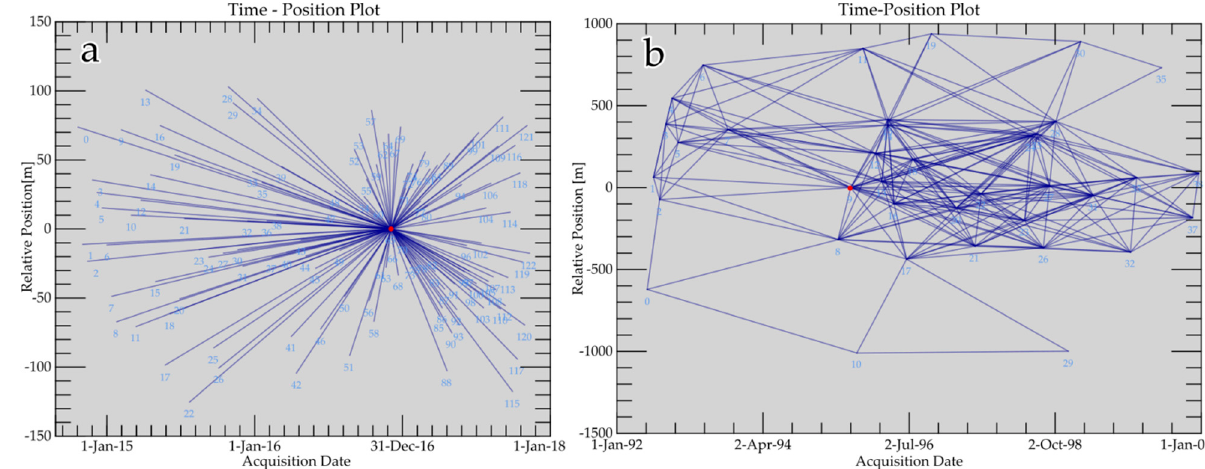
Figure 5. Example of connection graph for the interferogram generation: ( a ) Sentinel-1 ascending dataset with PSI technique, and ( b ) ERS ascending dataset with the SBAS algorithm. (high-resolution image available at https://doi.org/10.6084/m9.figshare.14915259.v1).